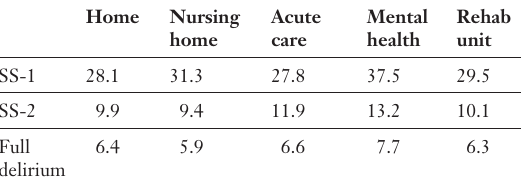
Variables associated with NHCAM.